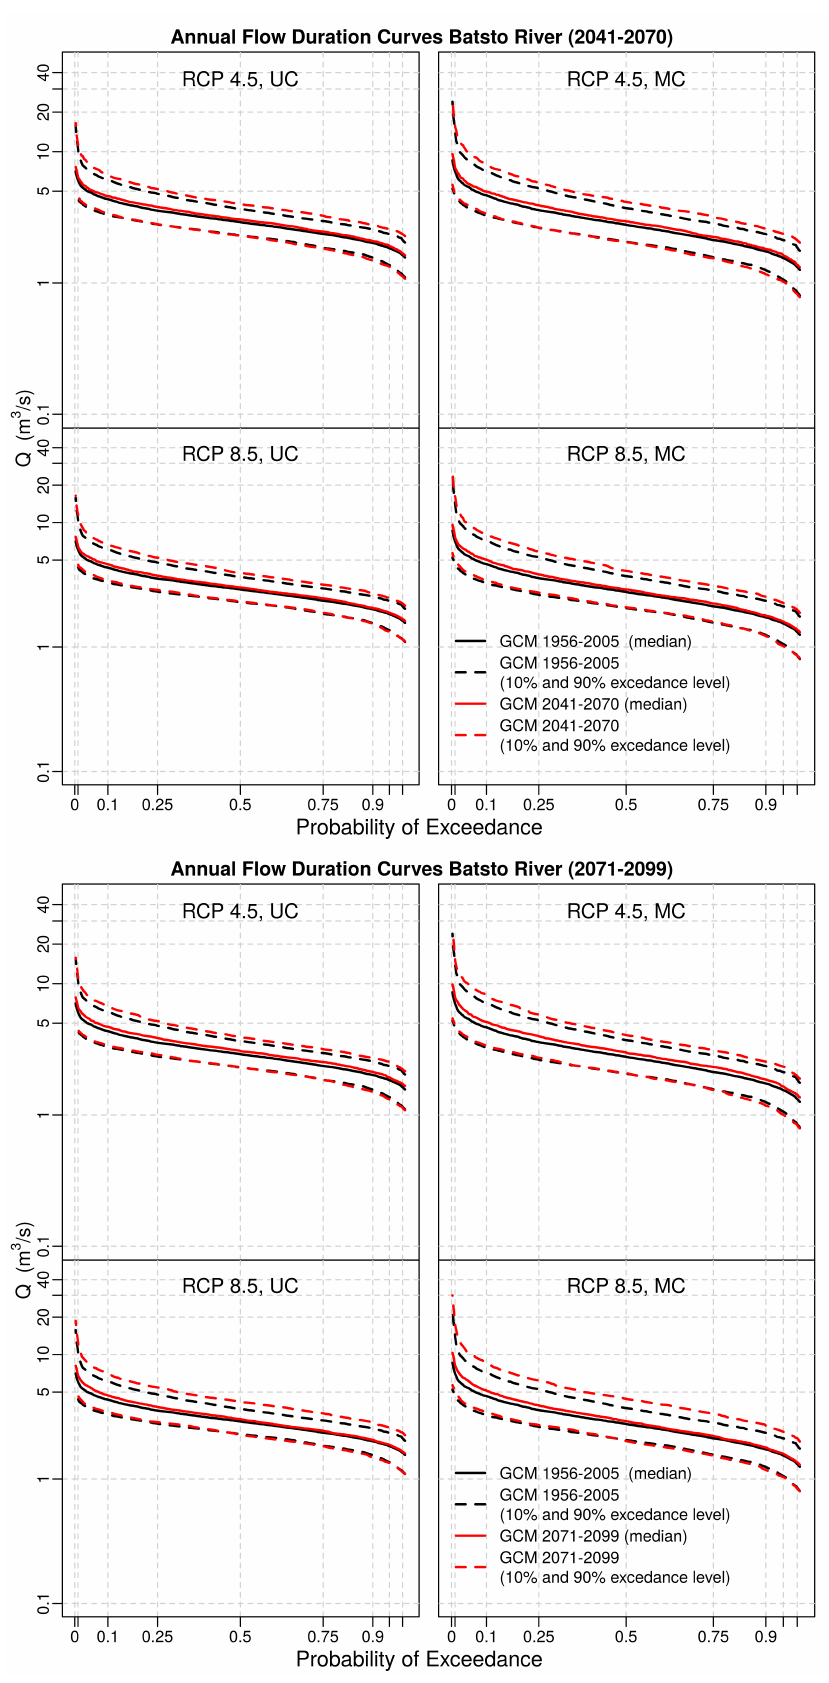
Figure 10. Projected flow duration curves for the Batsto River under emission scenarios RCP 4.5 and 8.5 for the two time slices as